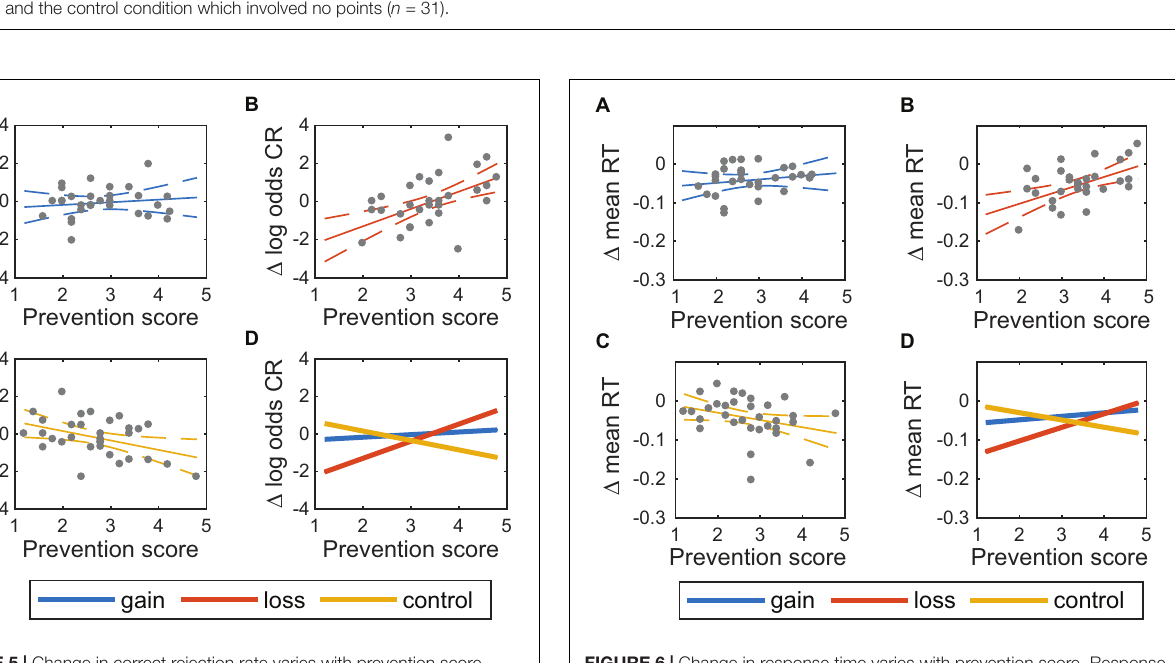
FIGURE 6 | Change in response time varies with prevention score. Response time (RT), summarized as the change in 20% trimmed mean, vs. prevention score for (A) gain condition, n = 31, (B) loss condition, n = 30, and (C) control condition, n = 32. Solid lines show the expected mean, and dashed lines show a 95% confidence region around the expected mean. (D) Expected means for all three